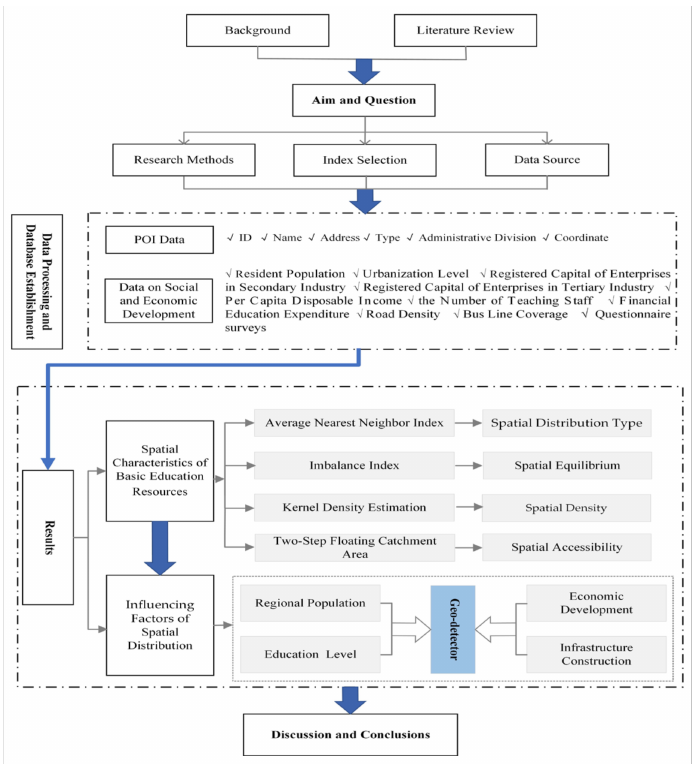
Figure 1. Research framework and